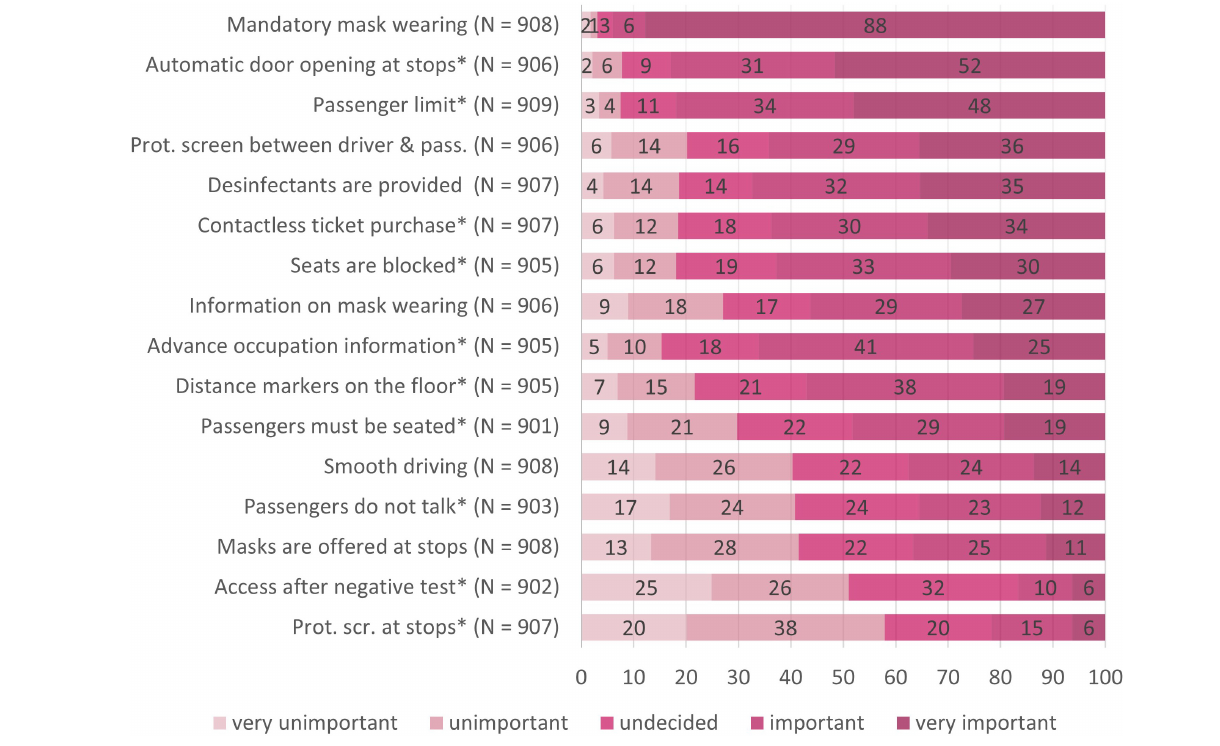
FIGURE 9 | Evaluation of the different measures taken against COVID-19 in public transport. N = 918; numbers on the bars represent percentages. *Indicates that significant differences ( p < 0.003) were found between the target groups in evaluating this